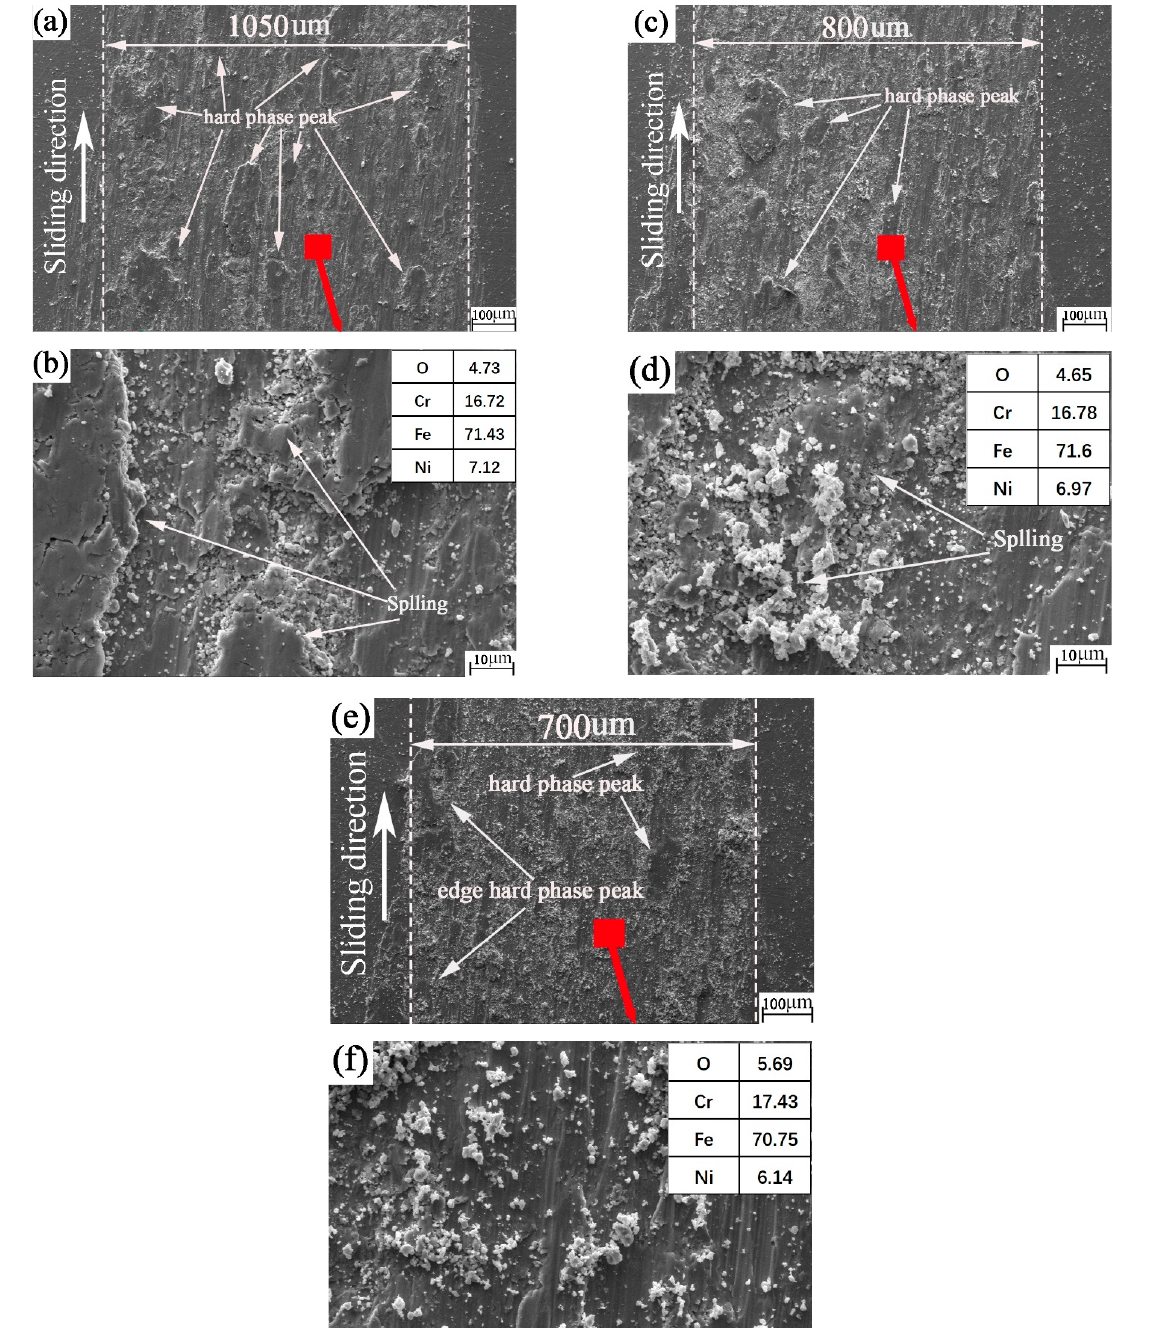
Figure 6. SEM and EDS images of the nanosecond textured worn plates: ( a , b ) nanosecond texture rotation radius 15 mm; ( c , d ) nanosecond texture rotation radius 18 mm; ( e , f ) nanosecond texture rotation radius 22.5 mm.